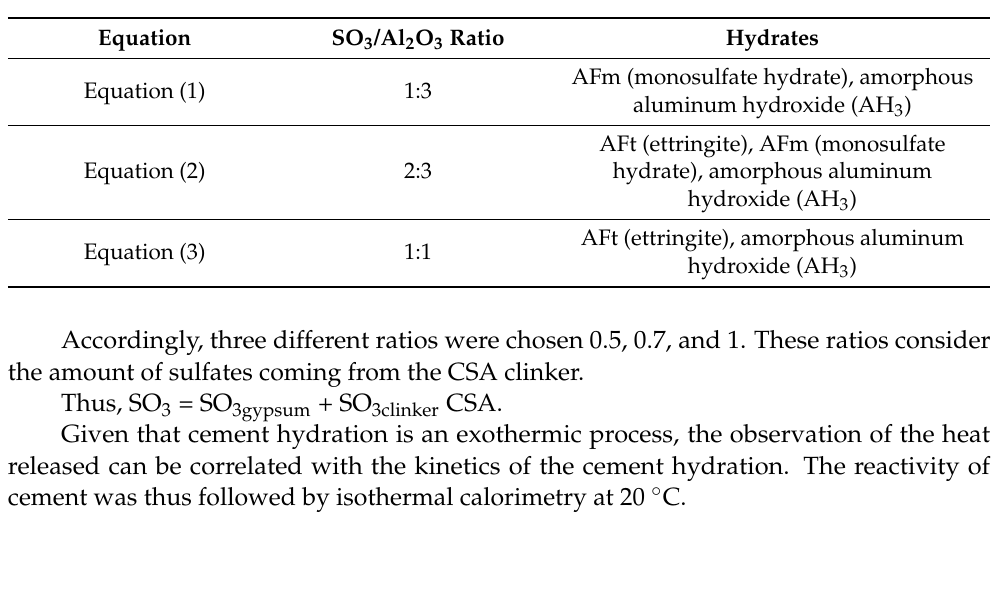
Table 3. Hydrates produced for each SO 3 /Al 2 O 3